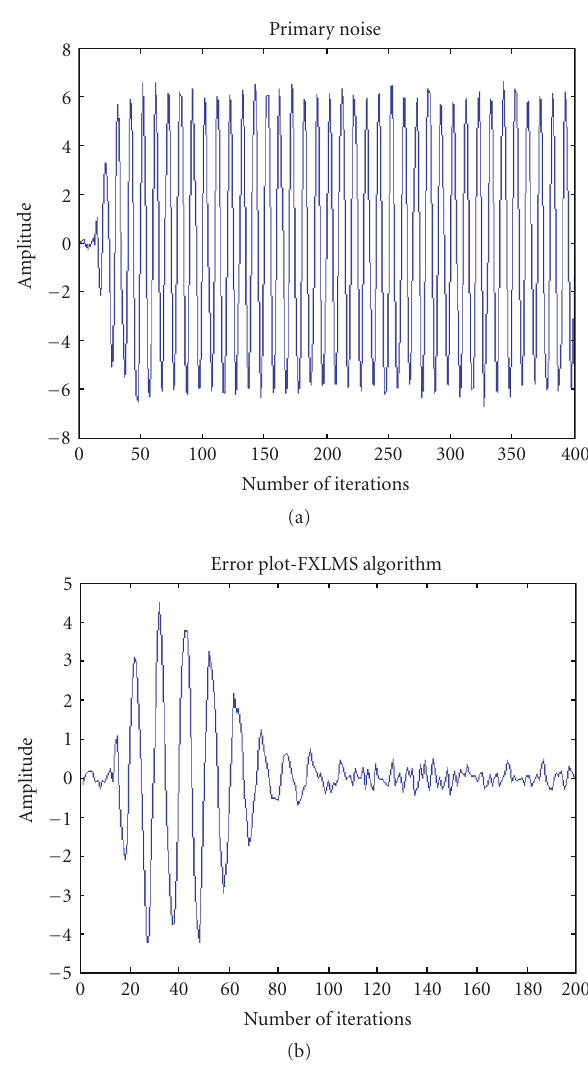
Figure 6: Results of the FXLMS algorithm: (a) primary noise and (b) residual